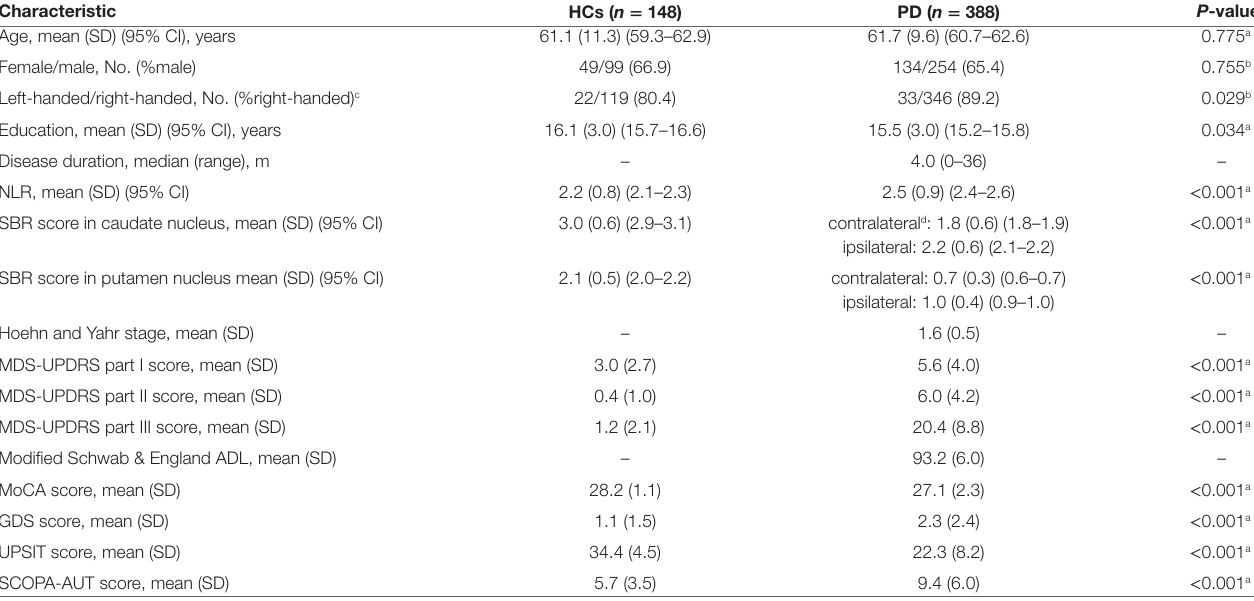
TaBle 1 | Demographic information and comparison of clinical outcomes between HCs and patients with PD.